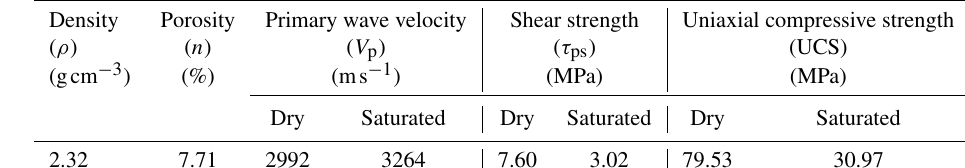
Table 1. The basic physico-mechanical properties of the fresh sandstone.